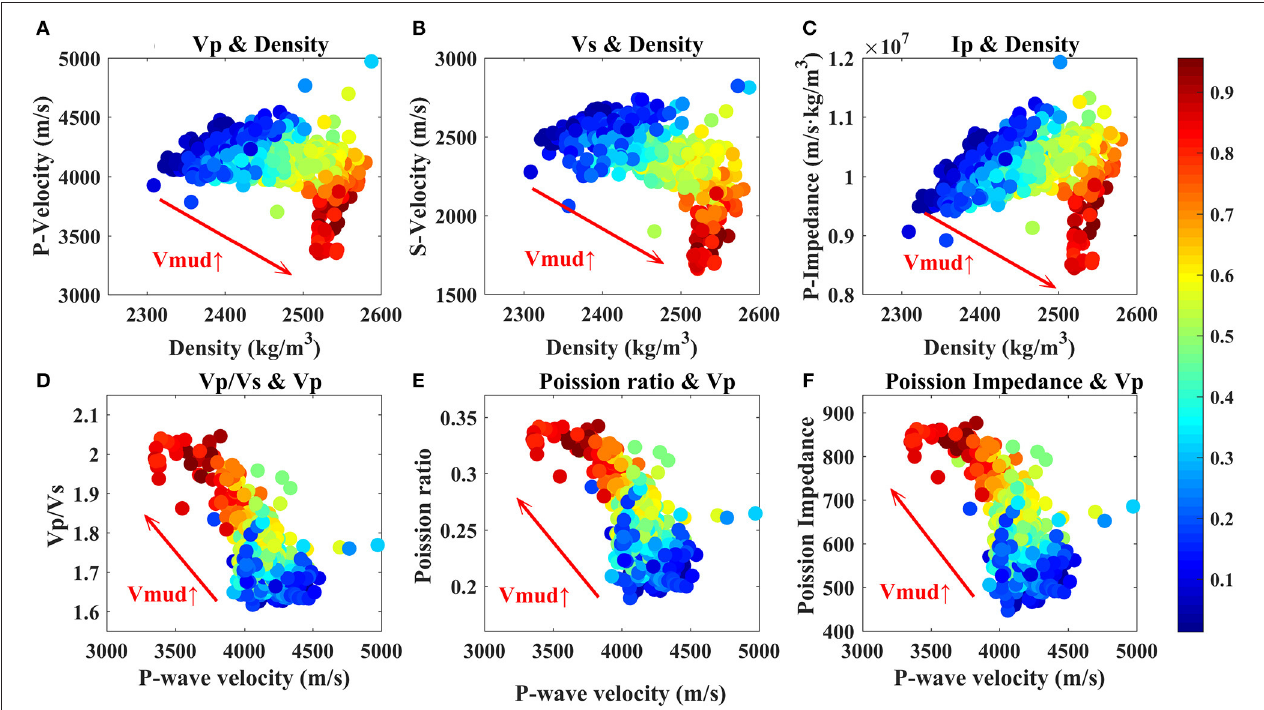
FIGURE 8 | Crossplot of elastic parameters versus mud content using actual well L2 data. (A) V p and ρ , (B) V s and ρ , (C) I p and ρ , (D) V p / V s and V p , (E) Poisson’s ratio and V p , (F) Poisson impedance and V p . The color bar on the right represents the mud content.